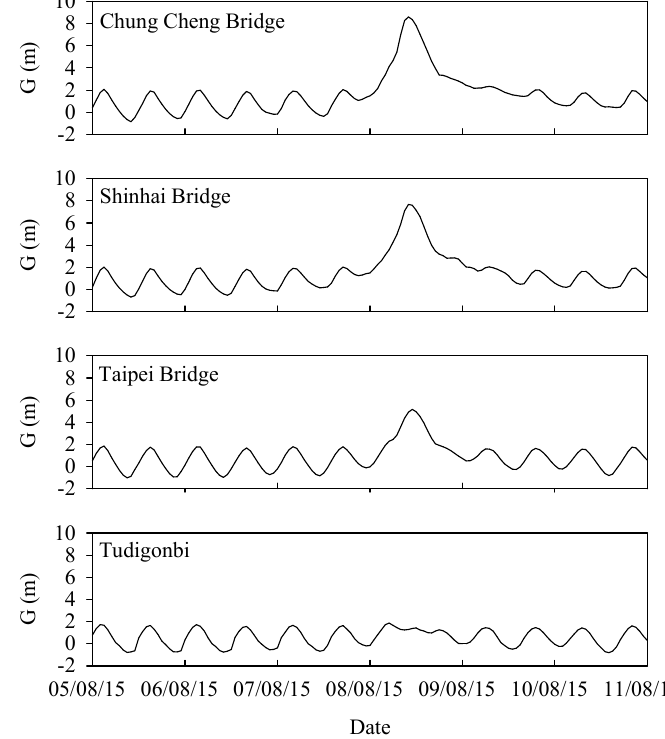
Figure 4. Water level hydrographs during Typhoon Soudelor. Table 1. Summary description of water levels at the Taipei Bridge during typhoons.